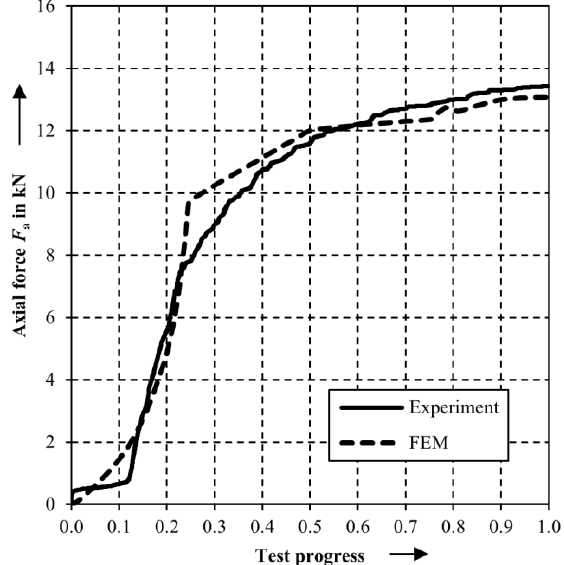
Figure 9. Axial force F a over test progress for the actuator with the cylinder diameter d c = 22.5 mm.